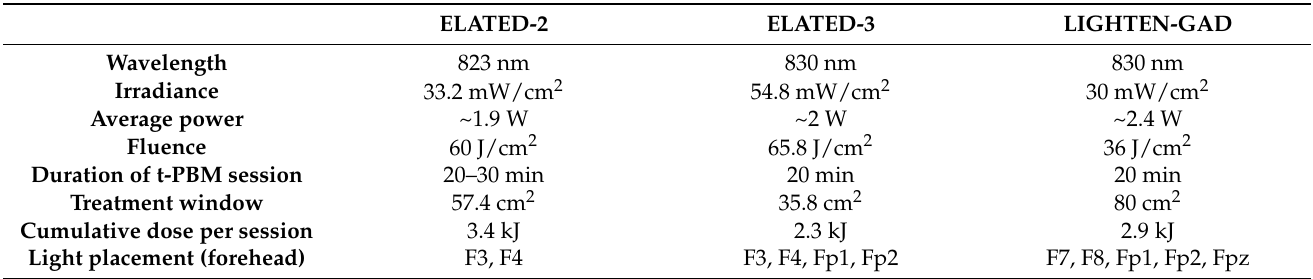
Table 1. Light output parameters of each